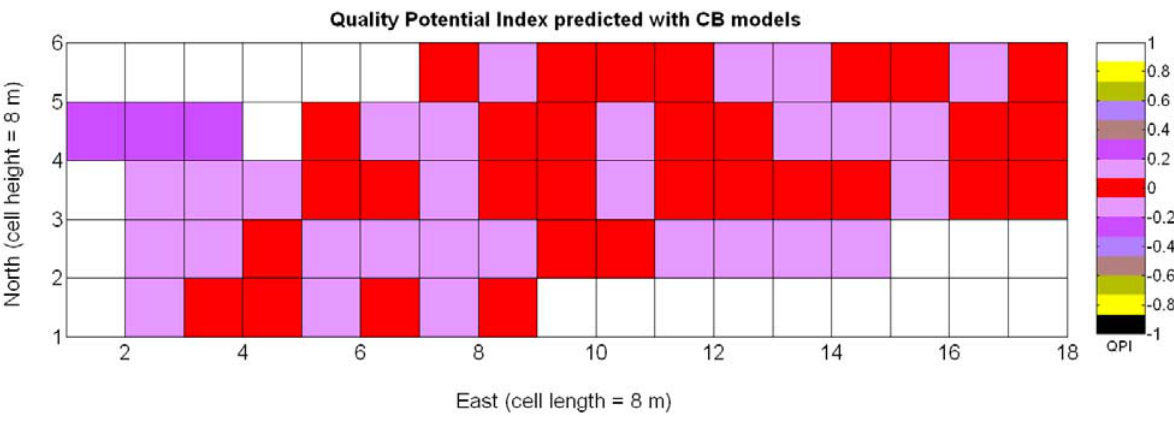
Figure 37. Quality Potential Index QPI predicted with CB models for low resolution